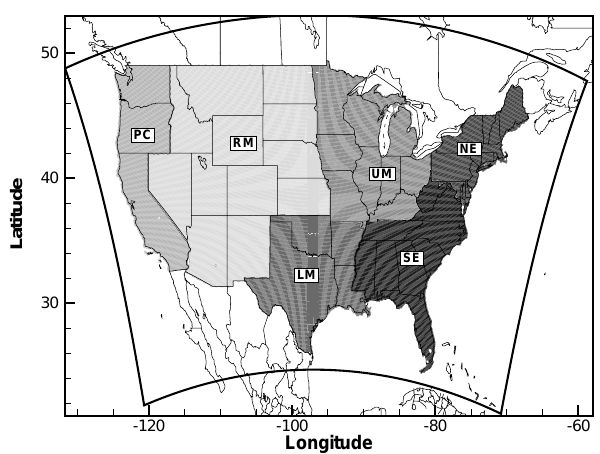
Fig. 1. NAQFC computational domain and six predefined US re- gions: Pacific Coast (PC), Rocky Mountain (RM), Southeast (SE), Lower Middle (LM), Upper Middle (UM), and Northeast